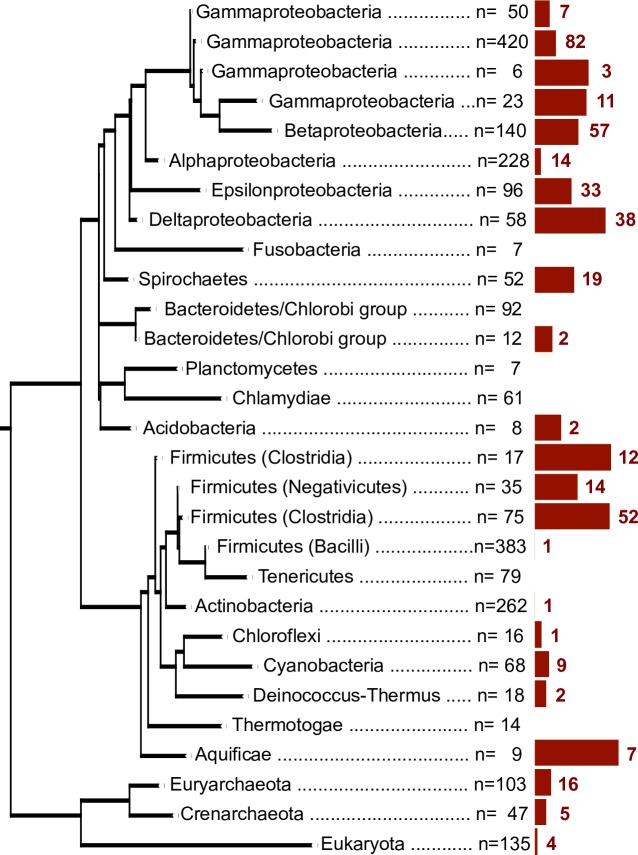
Relative fequency of genomes encoding for hemerythrin domain homologues across a species phylogeny.Phylogenetic tree based on a small subunit rRNA guide tree containing only completely sequenced species. Bacterial and archaeal species are collapsed on the phylum and group level. Eukaryotic species are collapsed together. n: number of species contained within each collapsed branch. The red bar is proportional to the number of species with at least one hemerythrin sequence in each collapsed branch. The total number of genomes with at least one O2-binding hemerytrhin is indicated by a red number next to the bar.